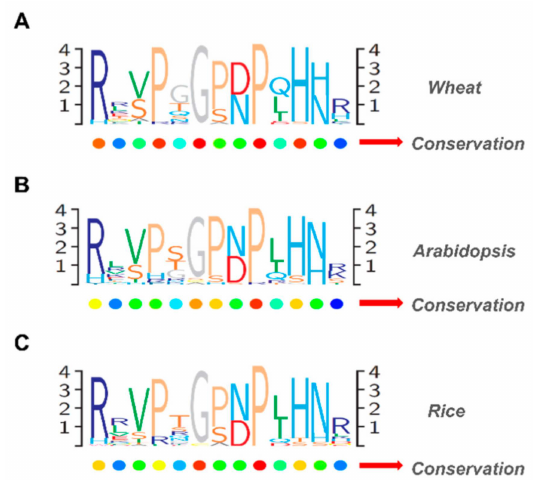
Figure 3. CLAVATA3 / EMBRYO SURROUNDING (CLE) domain consensus sequences from wheat pre-propeptides, Arabidopsis pre-propeptides, and rice pre-propeptides. Logo diagrams illustrate the 12 or 13 amino acid CLE domain consensus sequences for wheat CLE genes ( A ), Arabidopsis CLE genes ( B ), and rice CLE genes ( C